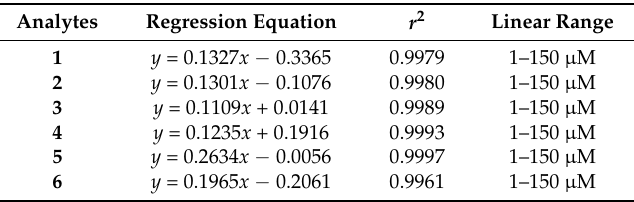
Table 2. The standard calibration curves of alkaloids 1 – 6 .